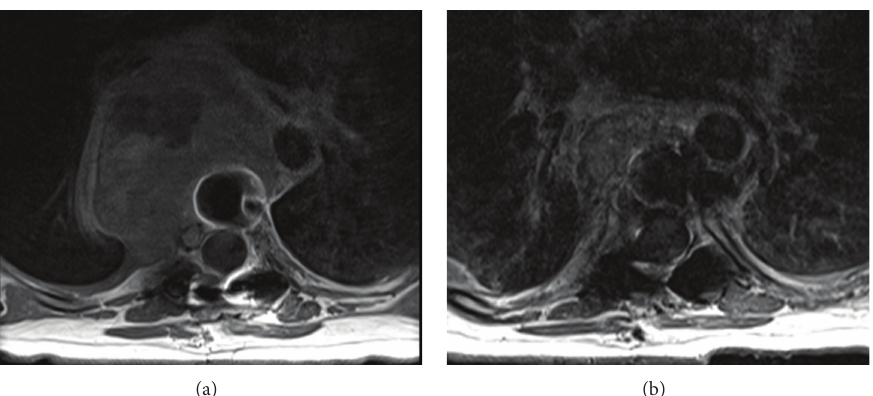
Figure 1: Axial T1 weighted postcontrast computed tomographic images show a large mid-thoracic spine mass (a) before and (b) 10 months after denosumab therapy.